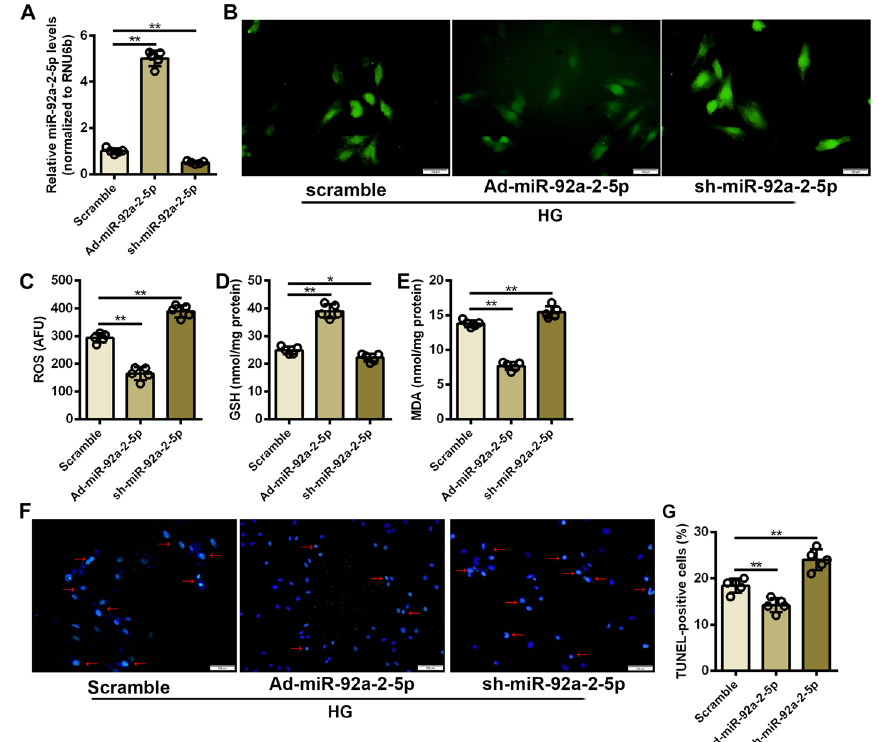
Fig. 3 Overexpression of miR-92a-2-5p attenuated oxidative stress injury in cardiomyocytes. A Relative expression levels of miR-92a-2-5p in cardiomyocytes infected with adenovirus. n 5 in each group. = ** P < 0.01. B Representative images of DCFH-DA staining in cardiomyocytes infected with adenovirus under high glucose stimulation. C - E Detection of ROS, GSH, and MDA levels in cardiomyocytes from the Ad-miR-92a-2-5p and sh-miR-92a-2-5p groups. n 5 in each group. ** P < 0.01. F Representative images = of TUNEL staining in cardiomyocytes infected with adenovirus under high glucose stimulation. The red arrows indicate the TUNEL-DAPI merge signals. G Detection of TUNEL-positive cardiomyocytes in the Ad-miR-92a-2-5p and sh-miR-92a-2-5p groups. n 5 in each group. ** P < =